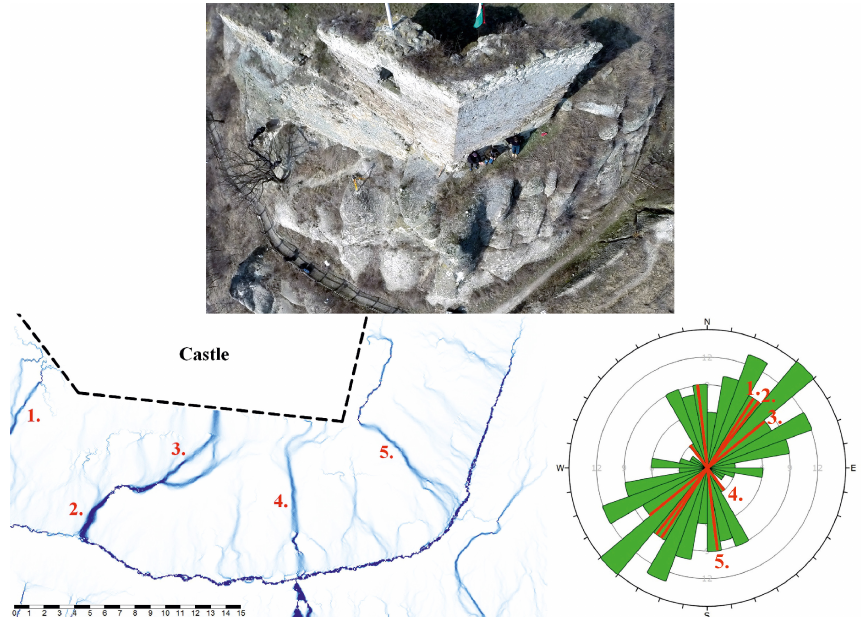
Figure 9. Top view of the cliff (see the location in Fig. 3) obtained with RPAS and the catchment area diagram obtained from DSM analysis by using a catchment area module (Costa-Cabral et al., 1994). The latter was used for joint pattern recognition. Numbers refer to major joint systems marked on the catchment area map and on rose diagram of the field measurements and DSM data set. Table 3. Rock mechanical parameters of tuff used in the model: lapilli tuff refers to upper and lower 4m, less welded tuff refers to middle stratigraphic unit. Mechanical property Upper and lower unit Middle unit (marked by A in Fig. 10) (marked by B–D in Fig. 10) (lapilli tuff) (less welded tuff) (kgm − 3 ) 1815